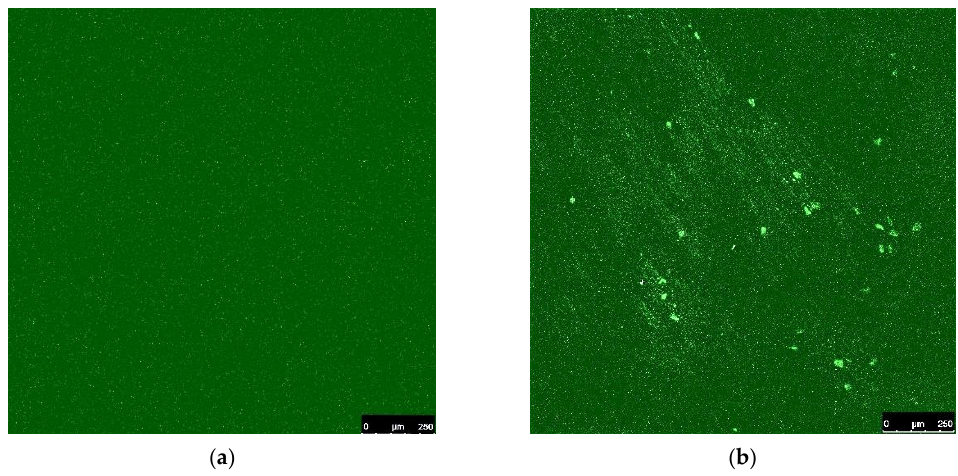
Figure 4. Rat brain slices: ( a ) after administration of free rhodamine B (2.5 mg/kg); ( b ) after intra- venous injection of rhodamine B (2.5 mg/kg) in 20 mM IA-16/PC (0.029/1) liposomes.